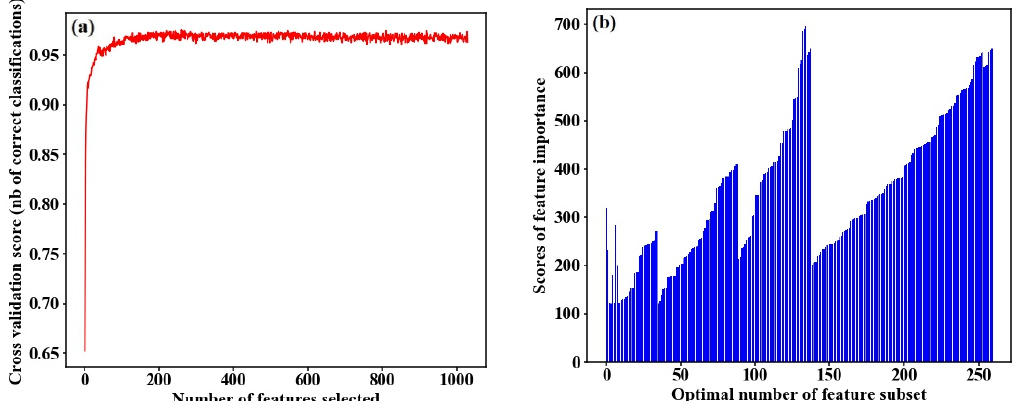
Figure 5. ( a ) Overall classification accuracy using the RF classifier with respect to different feature set obtained by the RFECV algorithm. ( b ) The importance scores of optimal number of features set.